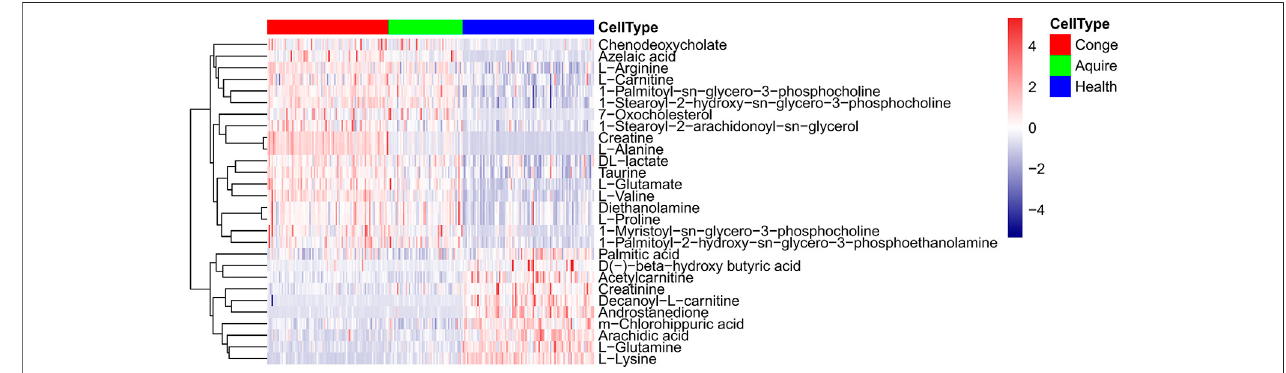
TABLE3| DifferentialmetabolitessharedincomparisonsofcomparisonA(Hypo-Pitvs.healthycontrols),comparisonB(congenitalvs.acquiredHypo-Pit),andcomparison C (hCG-sensitive vs. hCG-resistant).